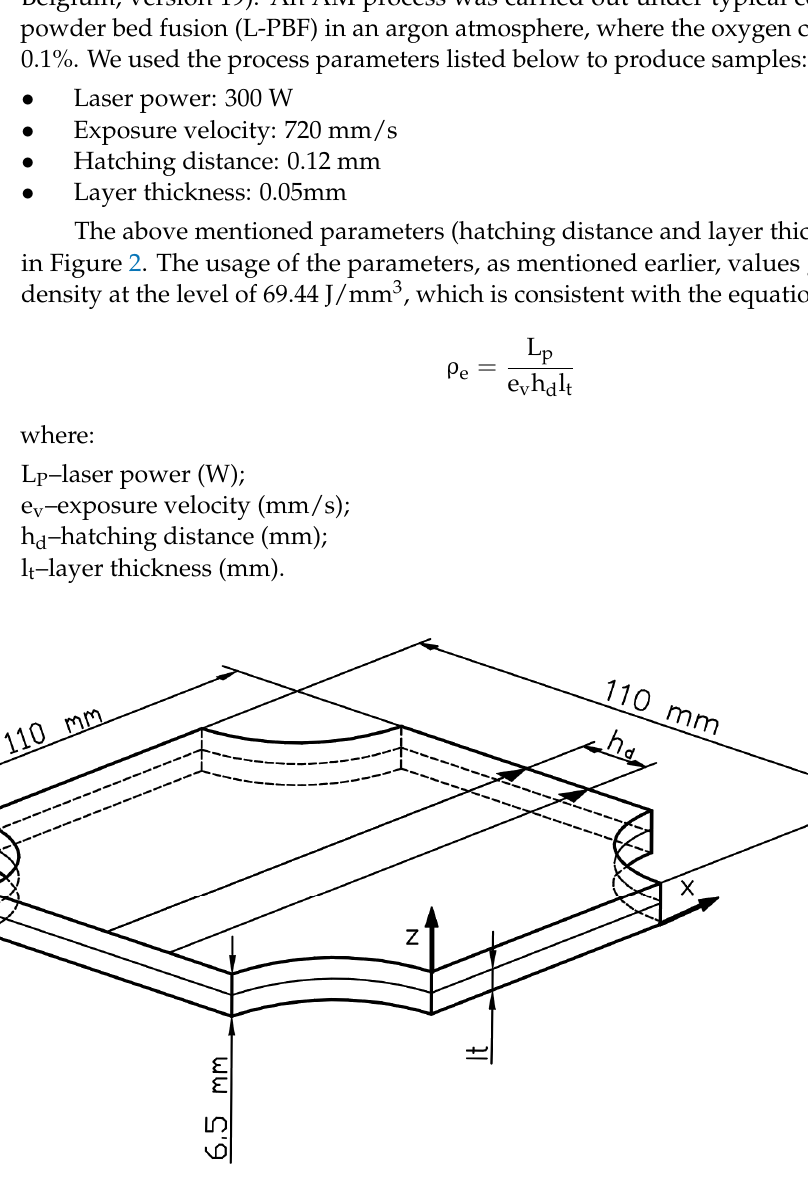
Figure 2. Explanation of layer thickness, hatching distance values, and sample plate dimension.